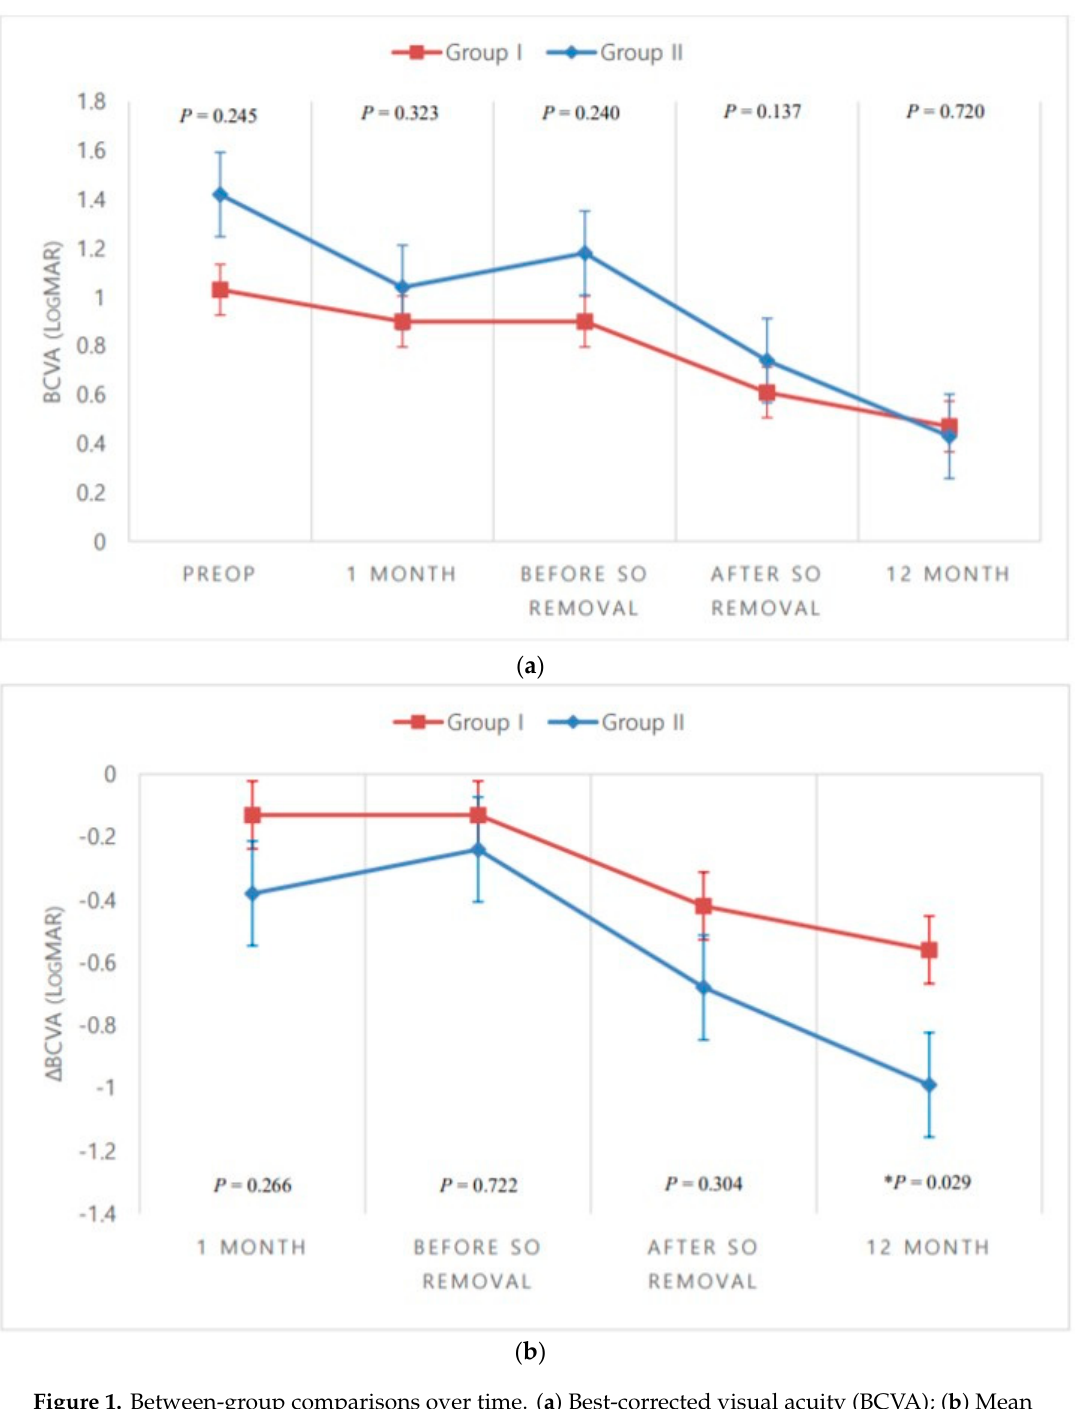
Figure 1. Between-group comparisons over time. ( a ) Best-corrected visual acuity (BCVA); ( b ) Mean change in BCVA from the preoperative (Preop) status. * p < 0.05, Mann–Whitney U -test. SO, silicone oil. Mean change in CMT also shows that the change increases as time passes in both groups. There was a statistically significant between-group di ff erence in mean change at 1 month postoperatively ( p = 0.027), but not immediately before SO removal, 1 month after SO removal, or 12 months postoperatively (Table 2, Figure